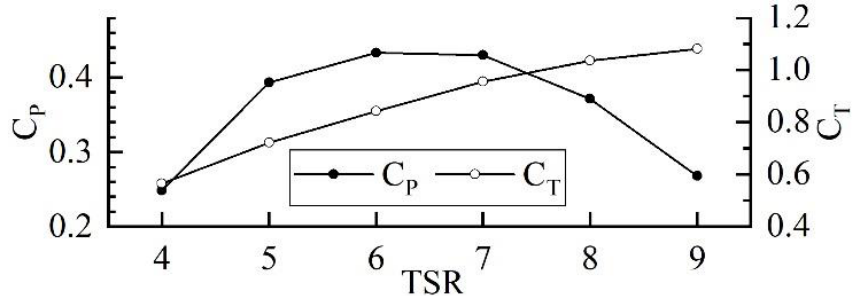
Figure 6. Performance of the BHATT with straight blades.